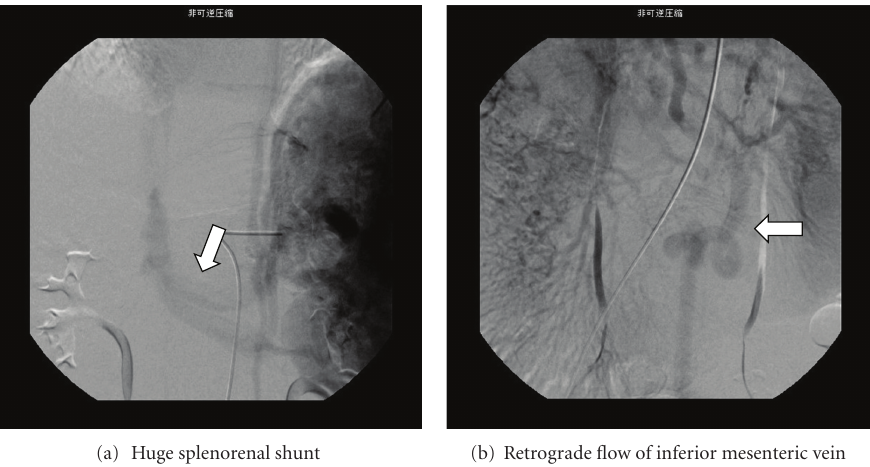
Figure 1: Preoperative angiography. (a) A huge splenorenal shunt (arrow) drained into the inferior vena cava without entering the hepatic hilum. (b) Retrograde flow in the dilated collateral vein (arrow) was observed.